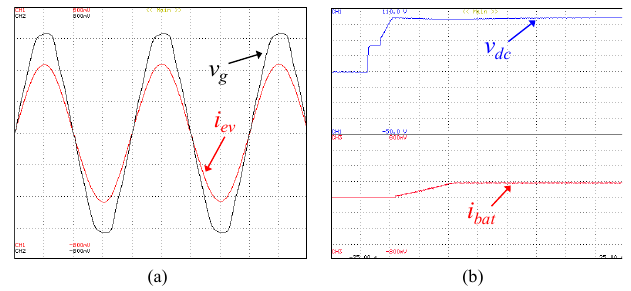
Figure 5. Experimental results: (a) Power grid voltage ( v g ) and EV current ( i ev ) in G2V mode; (b) EV battery current ( i bat ) and dc-link voltage ( v dc ) in the G2V mode.